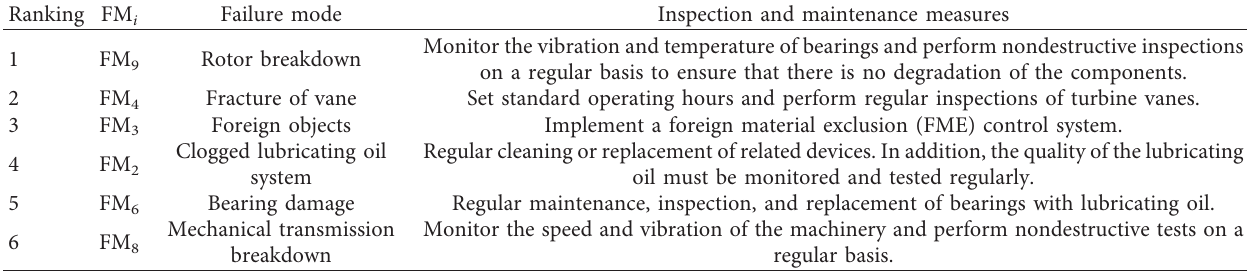
Table 5: Top six FMs as well as the inspection and maintenance measures for them. Ranking FM i